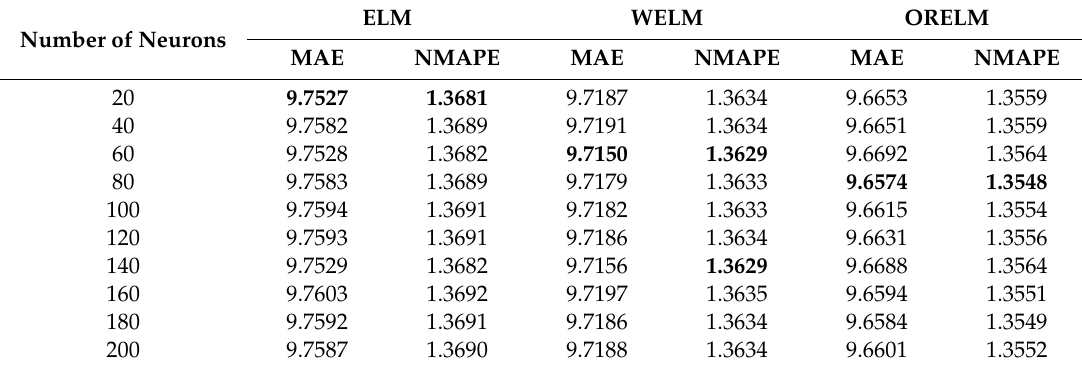
Table 7. Power curve modeling results of ELM-based models on validation set of Dataset D. Number of Neurons